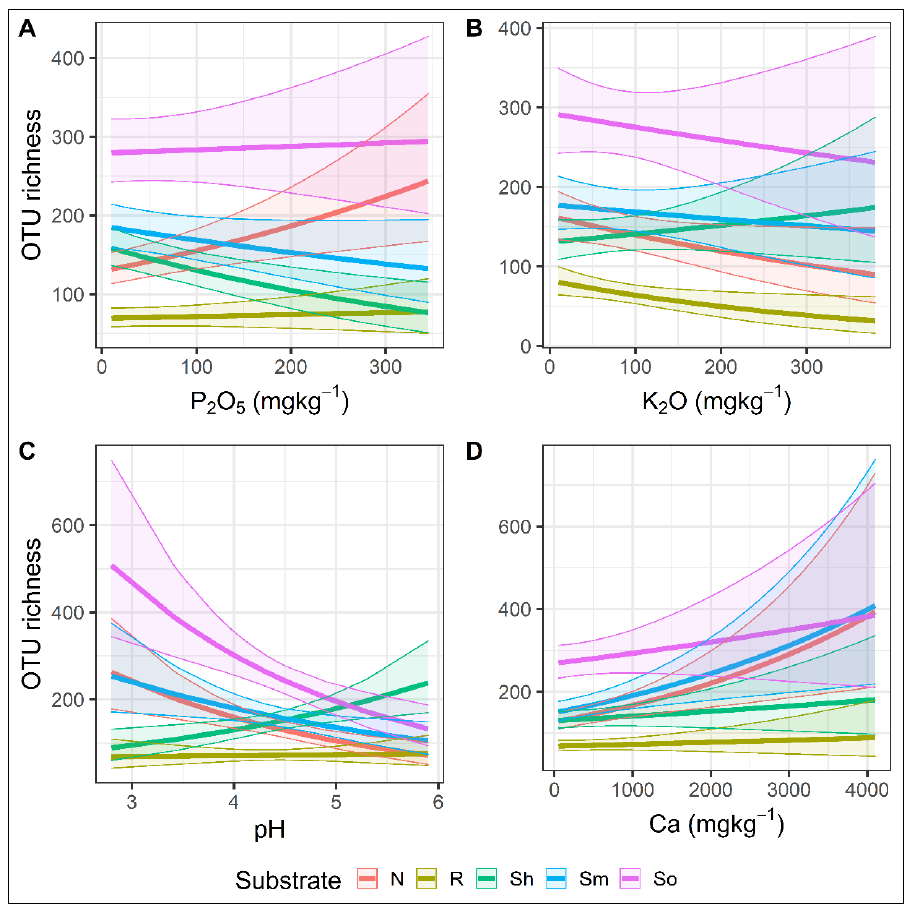
Figure 8. The relationship between the species richness of fungal OTUs in the different substrates (needles, shoots, roots, mineral, and organic soil) of Pinus sylvestris and different soil parameters ( A – D ). The semitransparent field around each curve denotes the size of the deviation from the mean value.